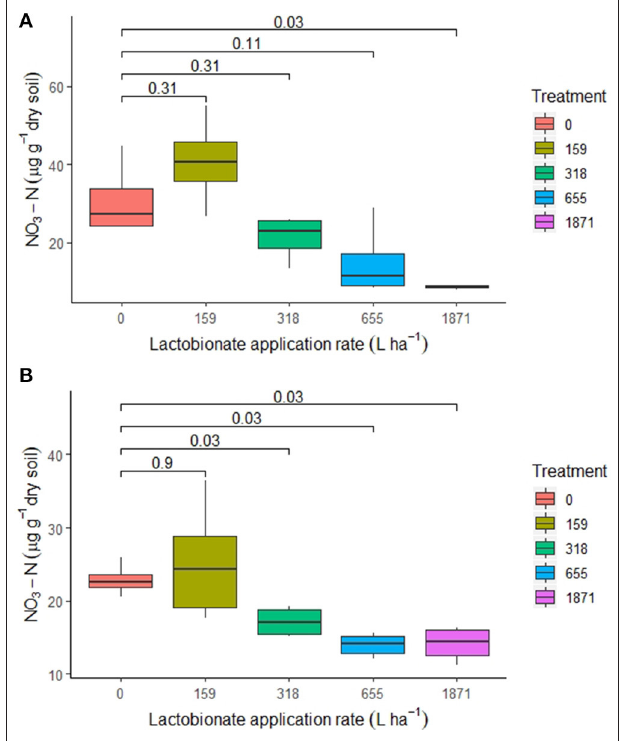
FIGURE 2 | (A) Effect of lactobionate application on soil nitrate-N for wheat trial (0–5cm). (B) Effect of lactobionate application on soil nitrate-N for wheat trial (5–15cm). Horizontal lines and p -values above each boxplot is the pairwise comparison of each treatment and control.